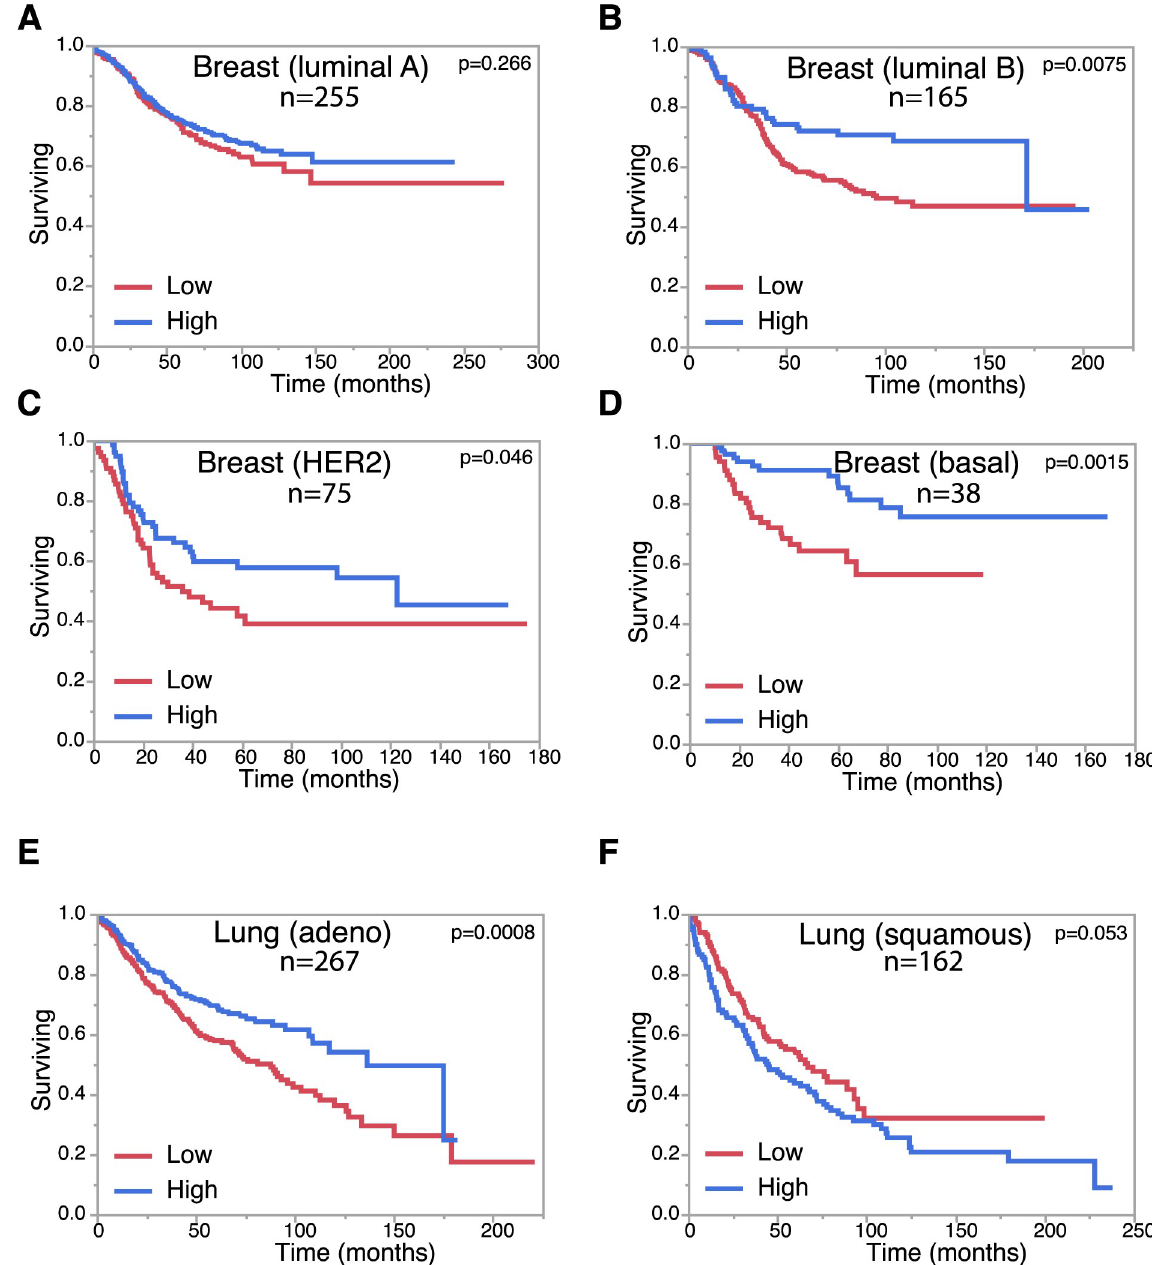
Fig 6. Altered GIRDIN expression correlates with survival in epithelial cancers. A - F , Kaplan-Meier survival plots for GIRDIN expression in breast cancer subtypes [luminal A ( A ), Luminal B ( B ), HER2-enriched ( C ), and basal ( D )], and lung cancer subtypes [adenocarcinoma ( E ), squamous ( F )]. p-values for differences between groups were determined using a Log-Rank